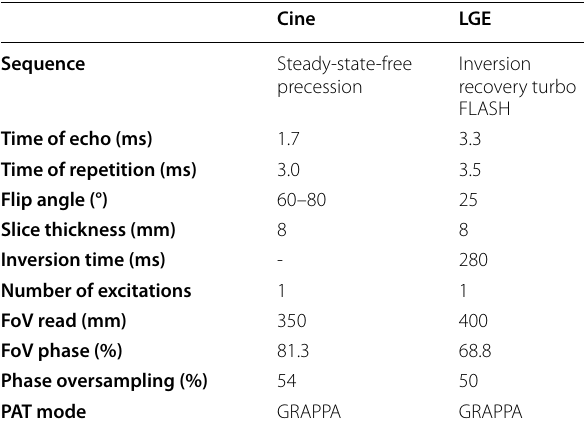
Table 1 Technical parameters for the main sequences used